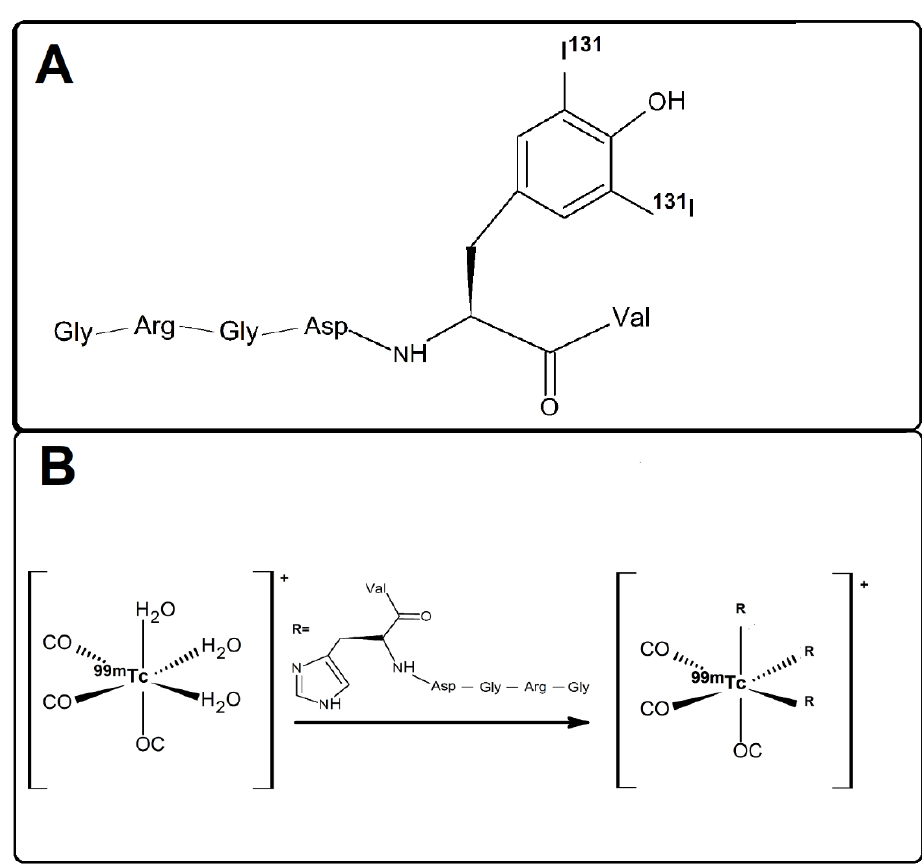
Figure 1. Molecular complexes of ( A ) [ 131 I]I-GRGDYV and ( B ) [ 99m Tc]Tc(CO) 3 -GRGDHV. The molecules were drawn using the ACD/Labs 2020 software (File Version C15E41, Build 117352, 2020), adapted from [18,19].